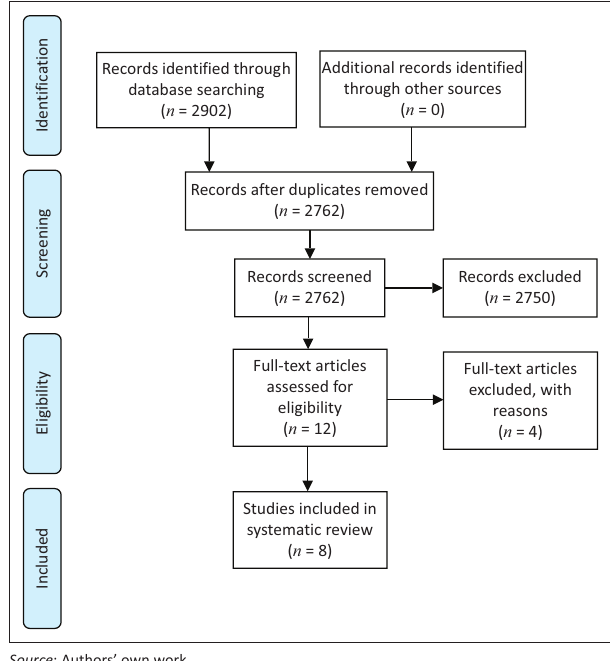
FIGURE 1: Preferred reporting items for systematic reviews and meta-analyses flow diagram showing the search results and inclusion of the